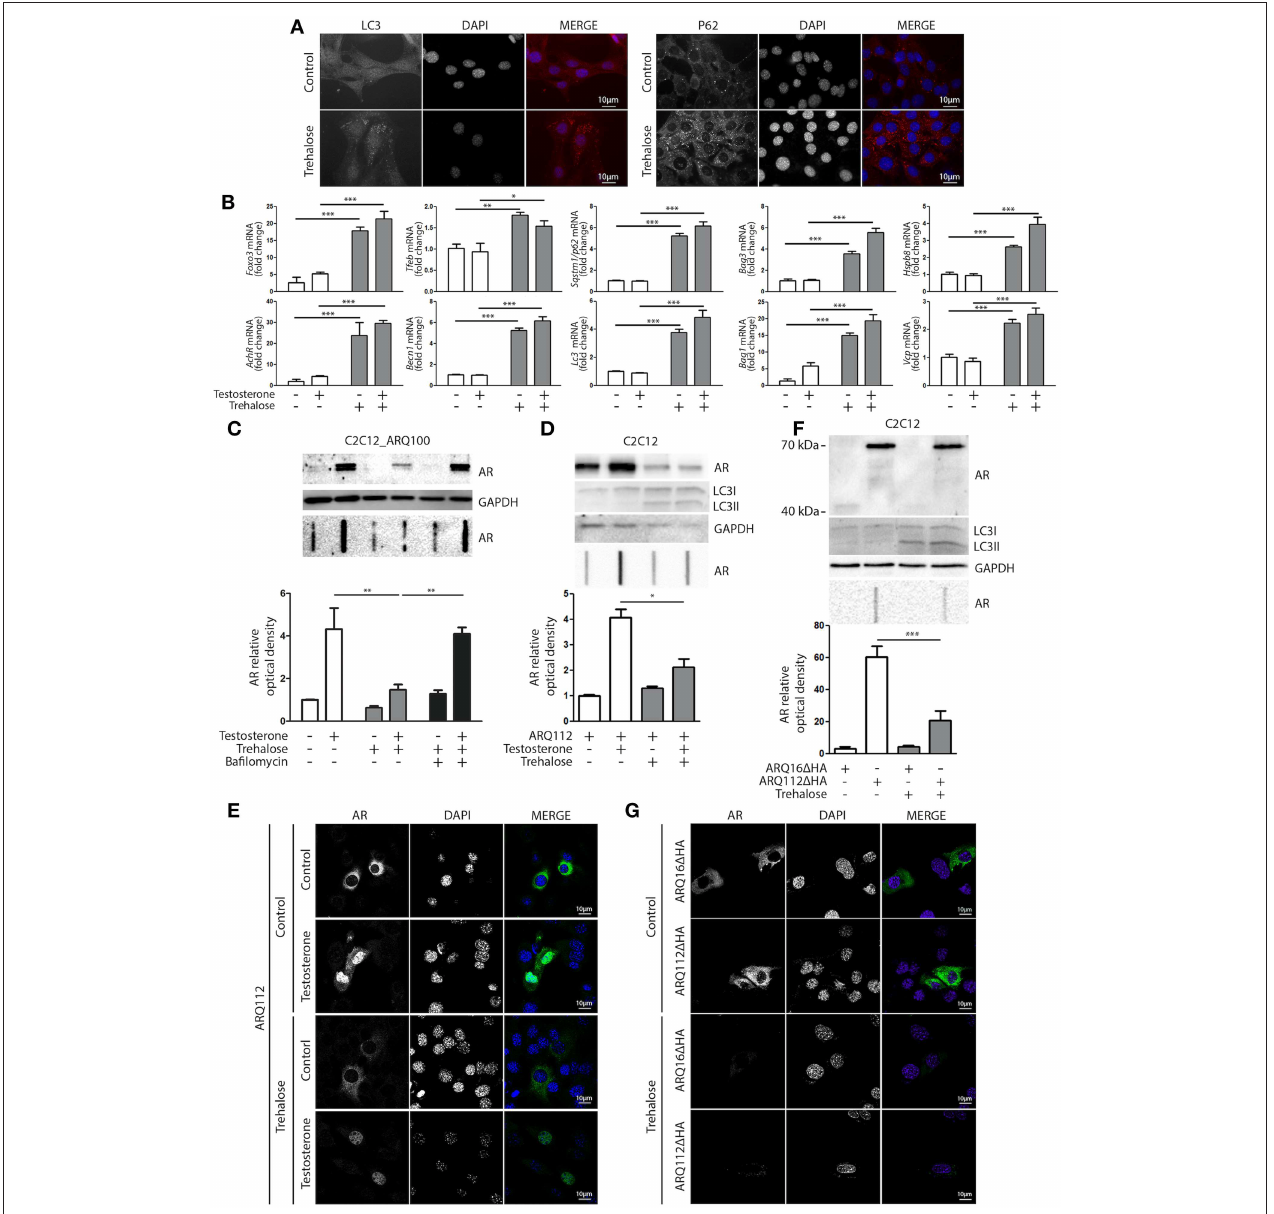
FIGURE 4 | Trehalose activates autophagy and reduces ARpolyQ accumulation (A) Immunostaining for LC3 (left inset) and p62 (right inset) of C2C12_ARQ100 in presence of trehalose. Nuclei staining: DAPI. Magnification: 63X. Microscope: Axiovert 2000 (B) C2C12_ARQ100 treated with trehalose. RTqPCR of PQC system related genes. (** p < 0.01; *** p < 0.001 vs. relative untreated control). (C) C2C12_ARQ100 treated with trehalose and bafilomycin A1. WB (upper inset) and FRA (middle inset) of PBS extracts of Optical densitometry quantification of FRA (lower panel) (** p < 0.01 vs. relative untreated control; *** p < 0.001 vs. trehalose + T). (D,E) C2C12 transiently transfected with p5HBhARQ112 and treated with testosterone and trehalose. (D) WB (upper inset) and FRA (middle inset). Optical densitometry quantification of FRA (lower inset). * p < 0.05 vs. relative control conditions + T. (E) Immunostaining for AR. Nuclei staining: DAPI. Magnification: 63X. Microscope: confocal LSM510 Zeiss (F,G) C2C12 transiently transfected with pARQ16 1 HA or pARQ112 1 HA and treated with trehalose. (F) WB (upper inset) and FRA (middle inset). Optical densitometry quantification of FRA (lower inset). ** p < 0.01 vs. relative control conditions + T. (G) Immunostaining for AR. Nuclei staining: DAPI. Magnification: 63X. Microscope: confocal LSM510 Zeiss. Each experiment was independently replicated three times ( n = 3). Graphs show quantification of three independent biological samples ( n = 3).